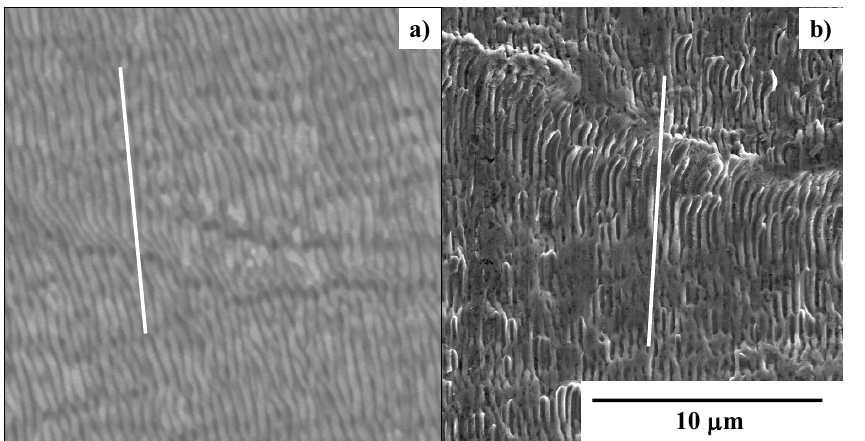
Figure 14. Comparison of SEM images at high magnification of the nano-textures between the 1 segment in the original M6 emblem on the die surface and the #1 segment in the M6 replica on the aluminum plate. ( a ) Original nano-textures, laser-printed on the AISI316L die, and ( b ) replica nano-textures, CNC-imprinted onto the aluminum plate.